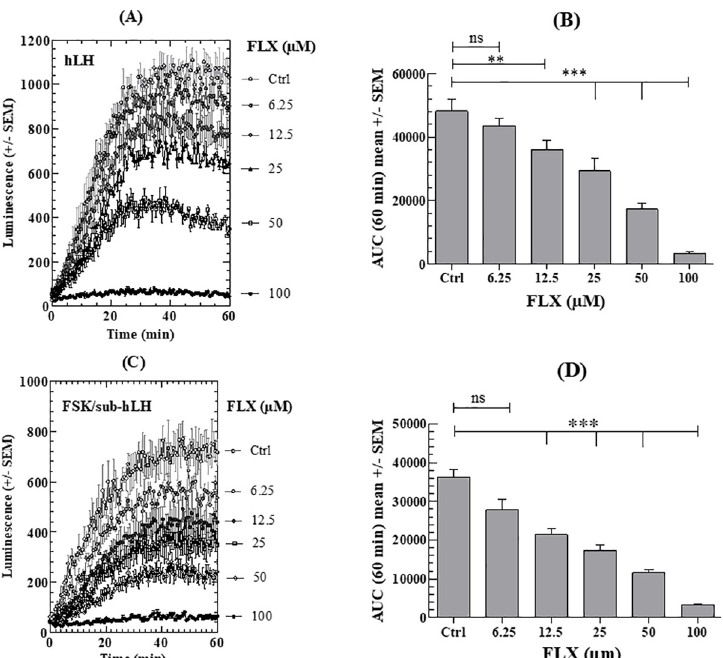
Fig 3. Effect of FLX on intracellular cAMP response of MLTC-1 cells to hLH or FSK/sub-hLH. (A), (C) Real-time recording of luminescence under stimulation of MLTC-1 cells by hLH and FSK/sub-hLH in the presence of 0 to 100 μ M FLX. (B), (D) Dose-dependent effects of FLX on hLH and FSK/sub-hLH responses respectively, determined by the Area Under Curve (AUC) of individual kinetics in Fig 3A and 3C. Data represent mean ± SEM of 3